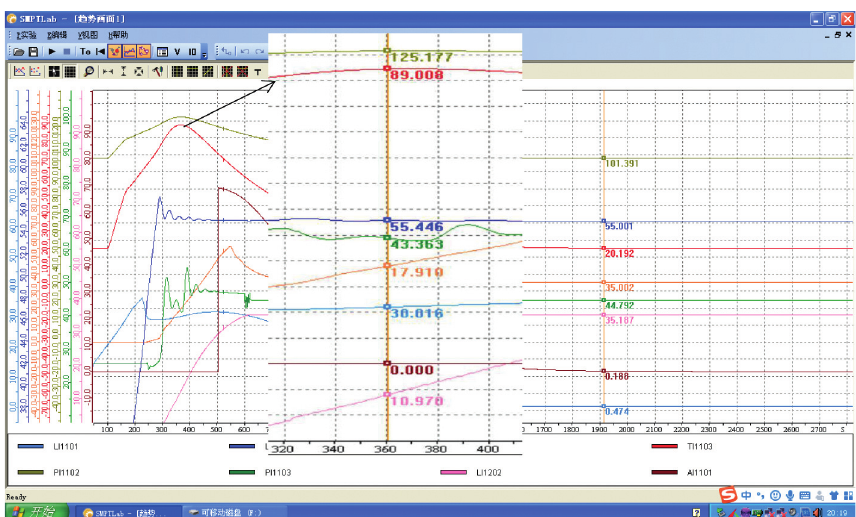
Figure 7: Original automatic disturbance rejection control iteration number 1000 of system trend graph.